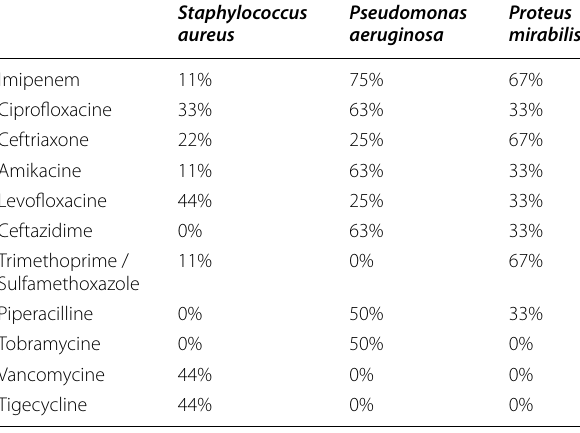
Table 6 Susceptibility rate of bacteria to antibiotics Staphylococcus